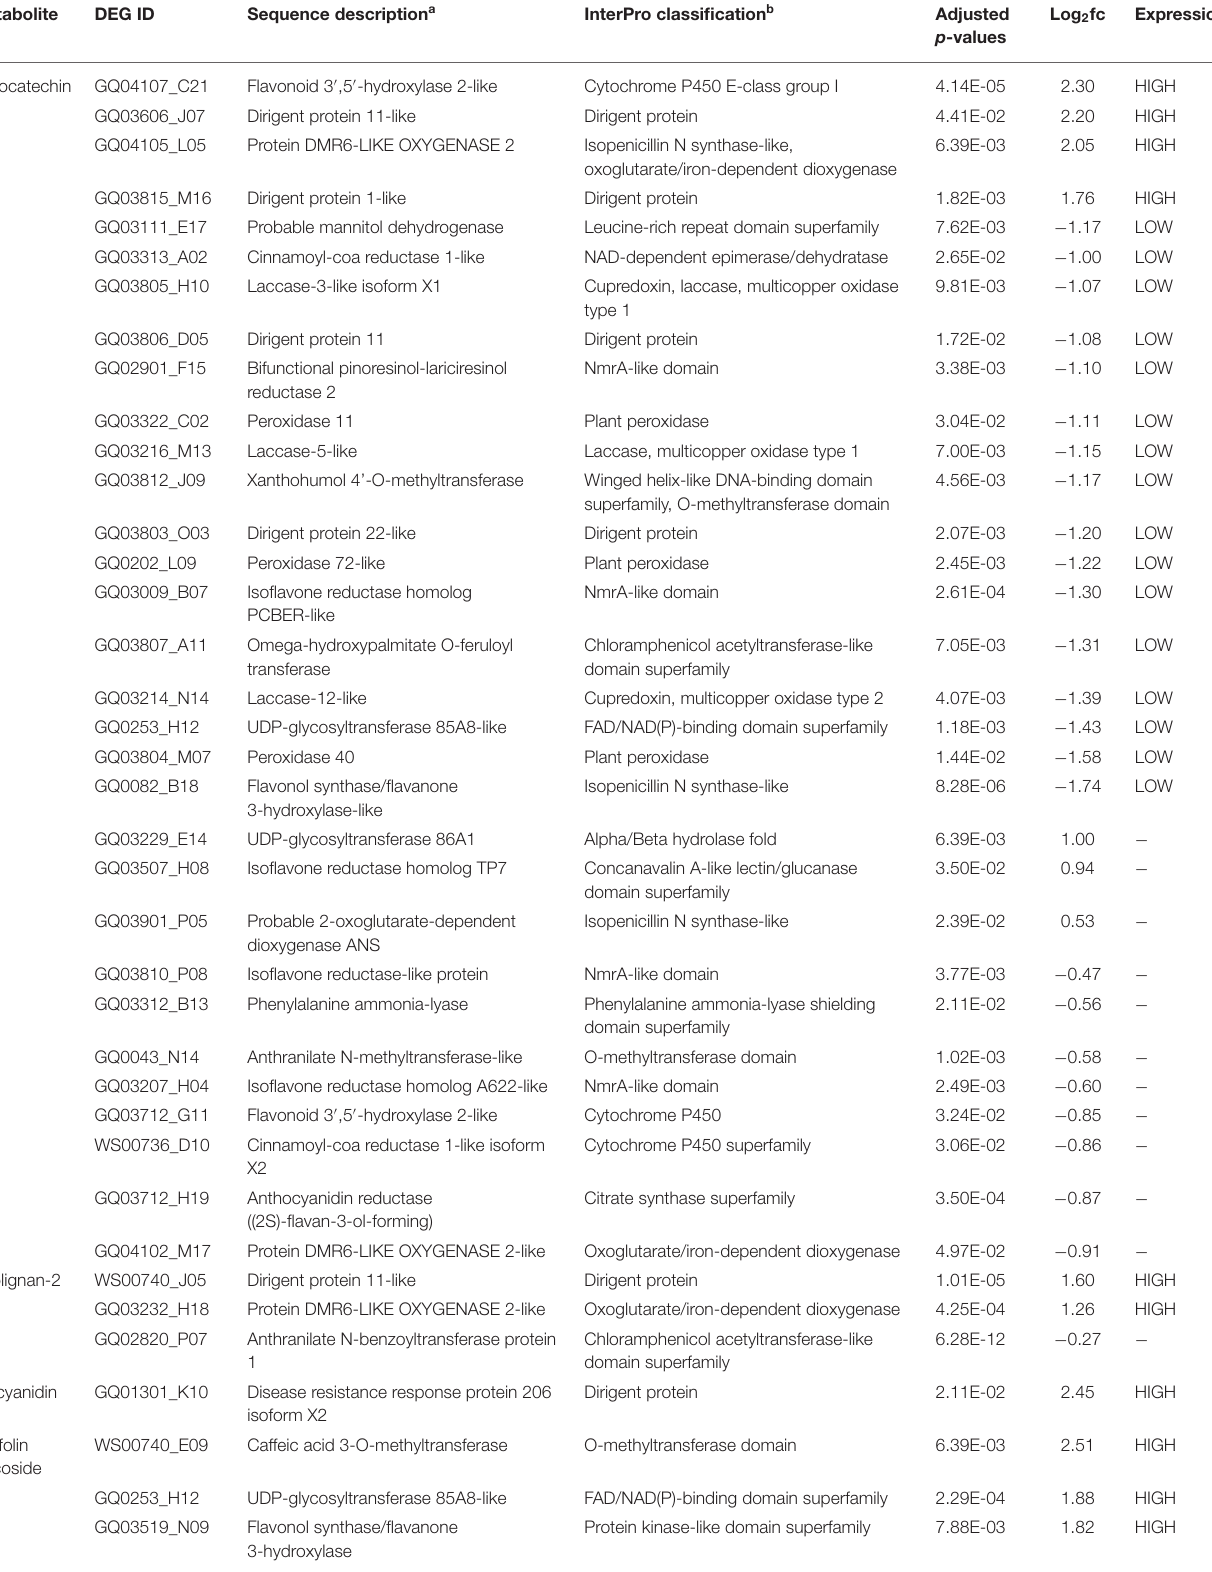
TABLE 3 | List of differentially expressed genes (DEGs; adjusted P < 0.05) involved in phenolic compounds metabolism.